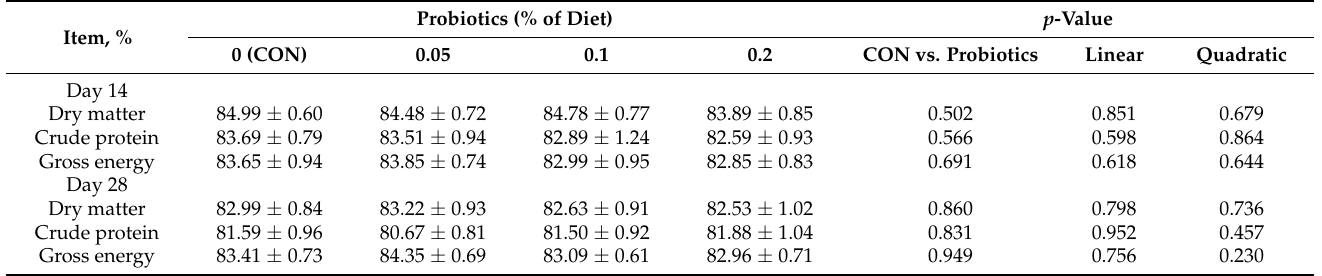
Table 4. Effects of dietary complex probiotic supplementation on nutrient digestibility in growing pigs.